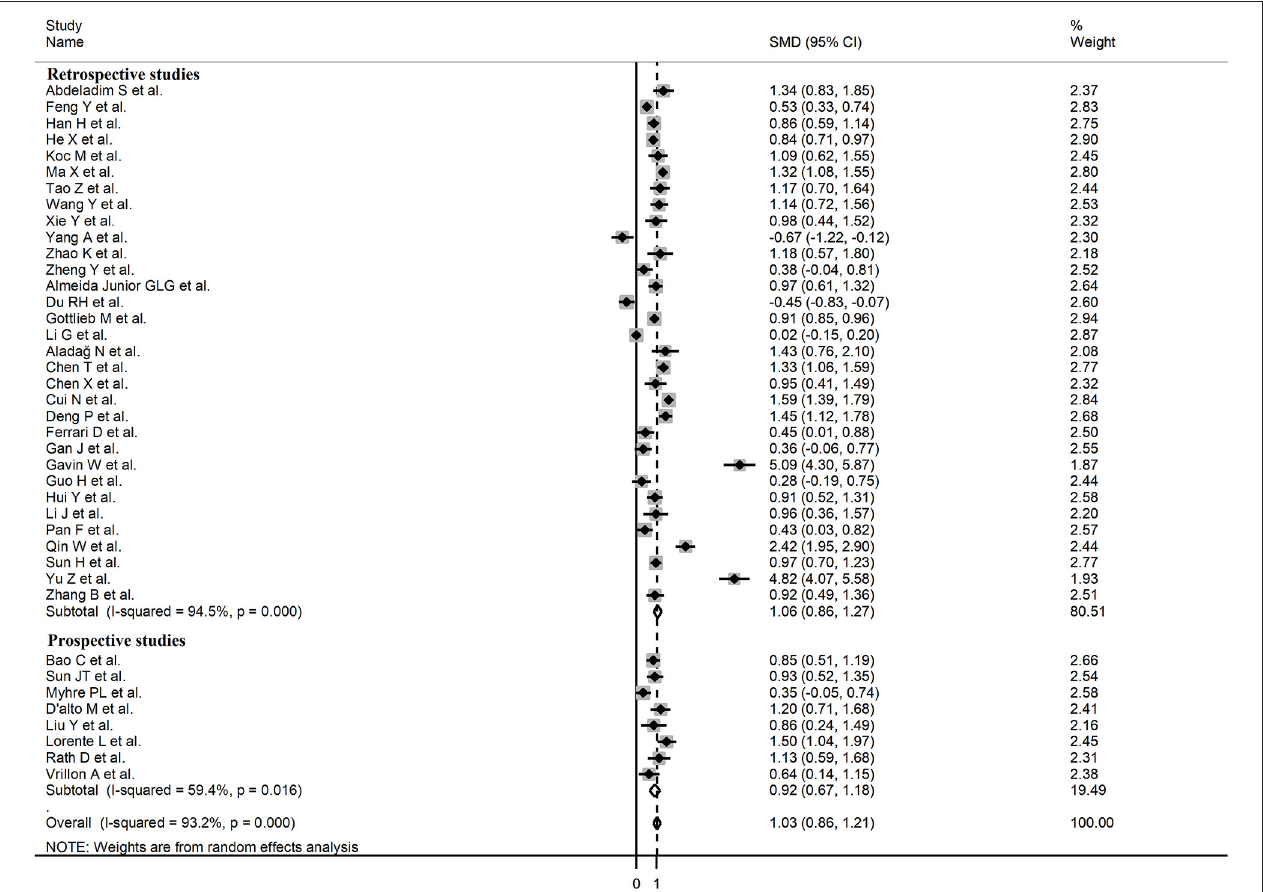
FIGURE 6 | Forest plot of studies reporting BNP concentrations in patients with COVID-19 according to study design (retrospective or prospective).